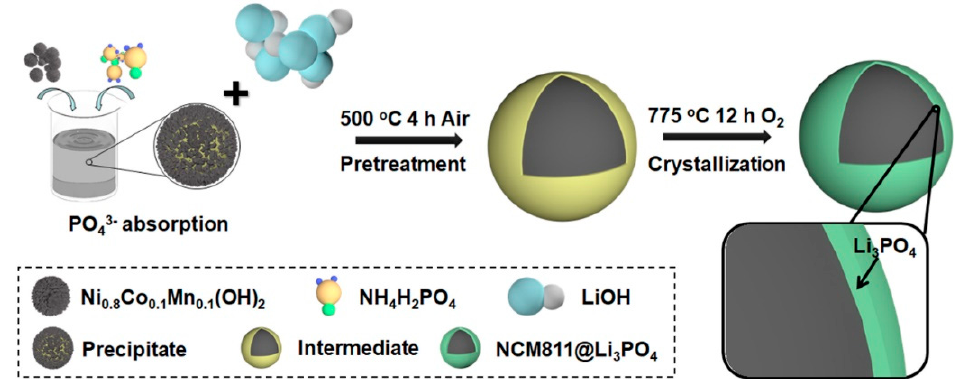
Figure 8. Schematic illustration for the fabrication of the NCM811@Li 3 PO 4 . Reproduced with permission from [180]. Copyright 2020 Elsevier.